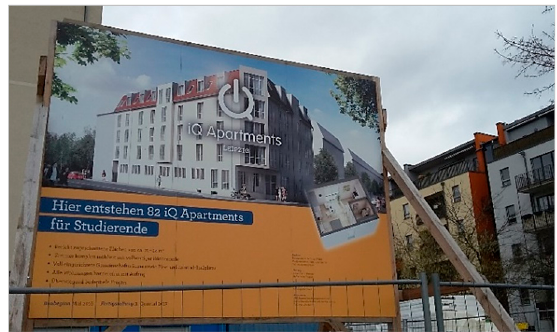
Figure 3. Billboard in Josephinenstraße: “We’re building 82 iQ apartments for students” (Photo: Lena Ali).